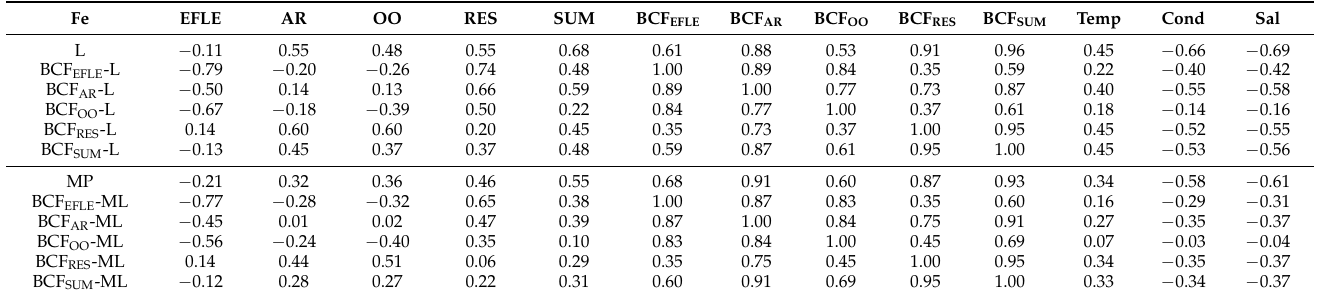
Table 4. Iron correlation coefficients between variable A (Fe levels in the lamina (L), midrib plus petiole (MP), and Fe bioconcentration factors (BCF)) and variable B (geochemical fractions in the sediments and surface water parameters). Values in red are significant at p <